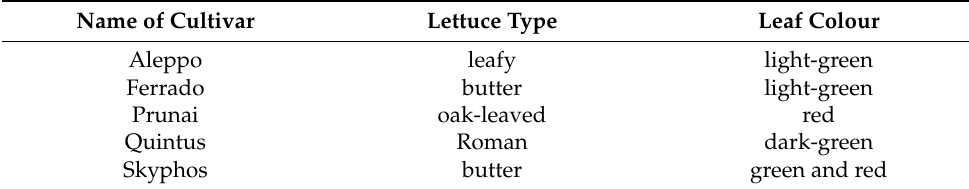
Table 1. The characteristics of lettuce